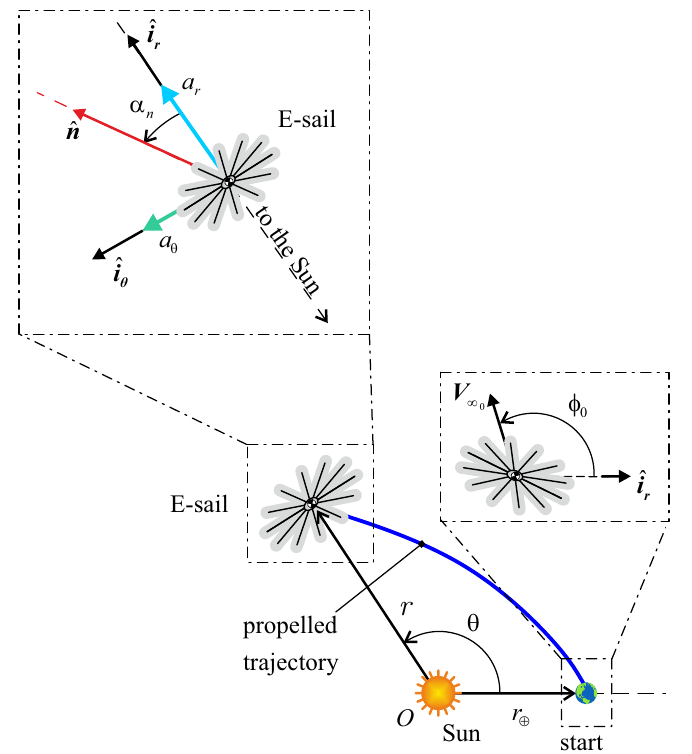
Figure 1. Reference frame and state variables in the proposed mission